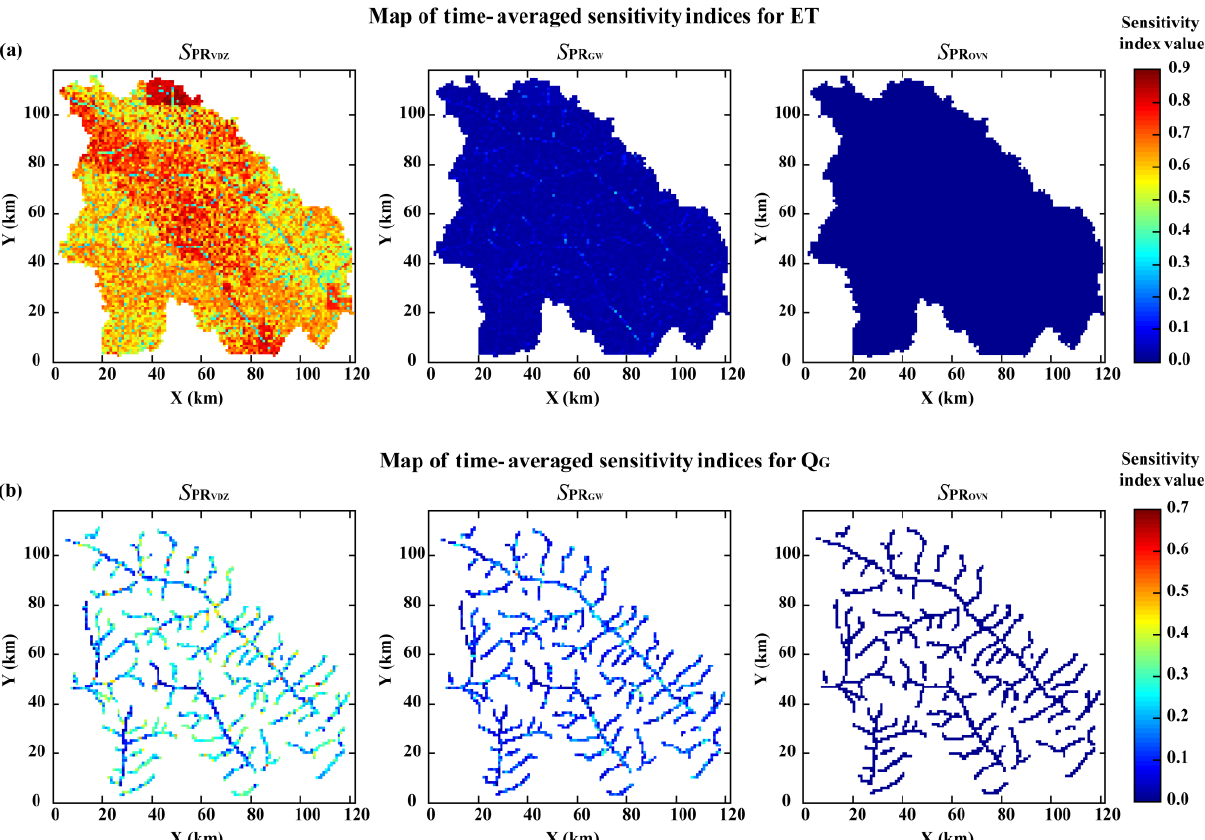
Figure 11. Maps of vadose zone parameter sensitivity indices ( S PR flow parameter sensitivity indices ( S PR ( Q G ) (b)